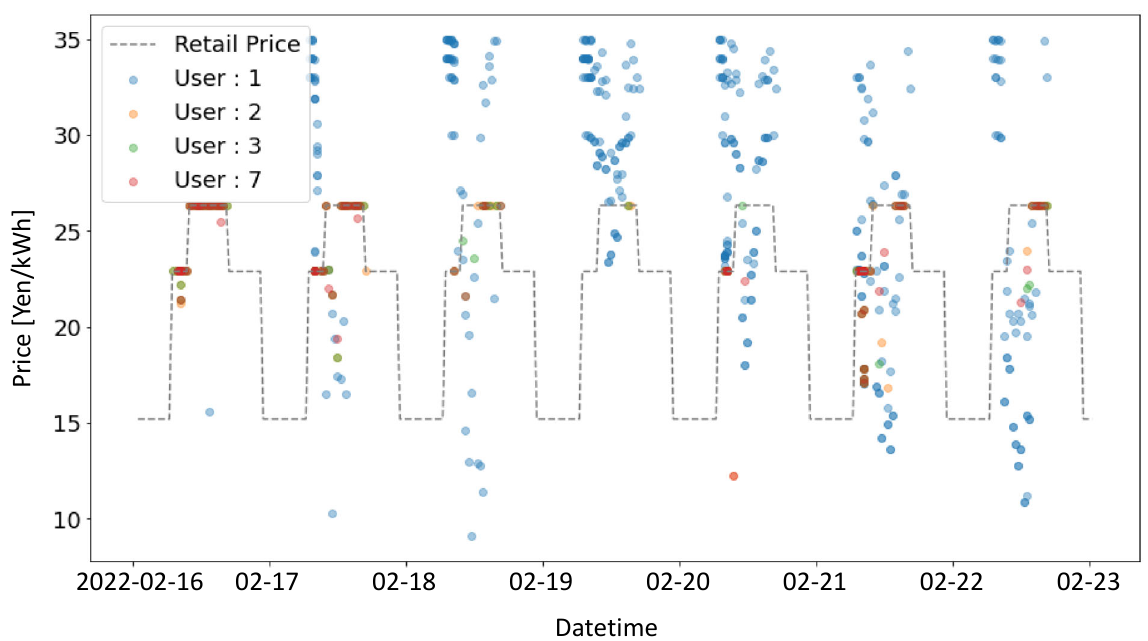
Figure 9. Trends in contract prices for all users in Phase 4 of the experiment.